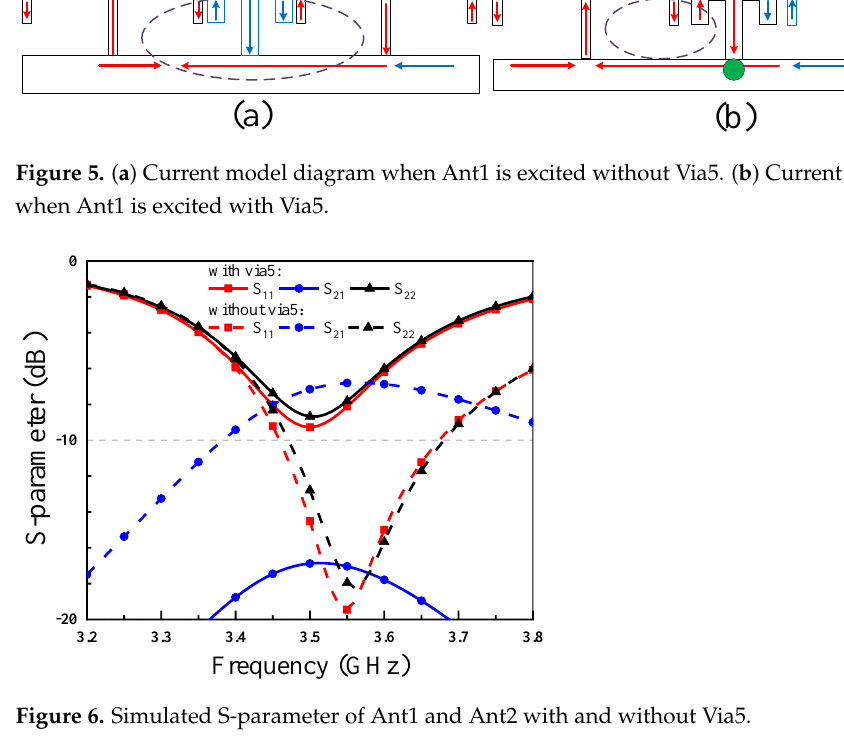
Figure 6. Simulated S-parameter of Ant1 and Ant2 with and without Via5.